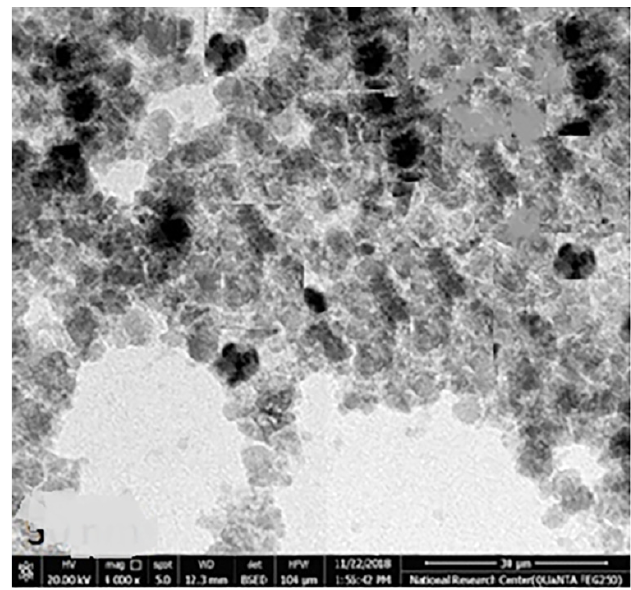
Figure 8. Transmission electron microscopy of HAPNPs.